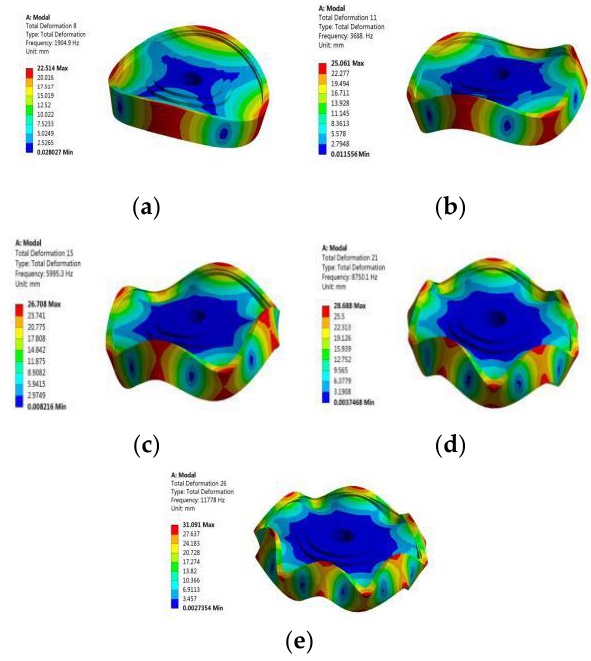
Figure 22. Rotor core axial flux mode shape. ( a ) Second order model. ( b ) Third order model. ( c ) Fourth order model. ( d ) Fifth order model. ( e ) Sixth order model.